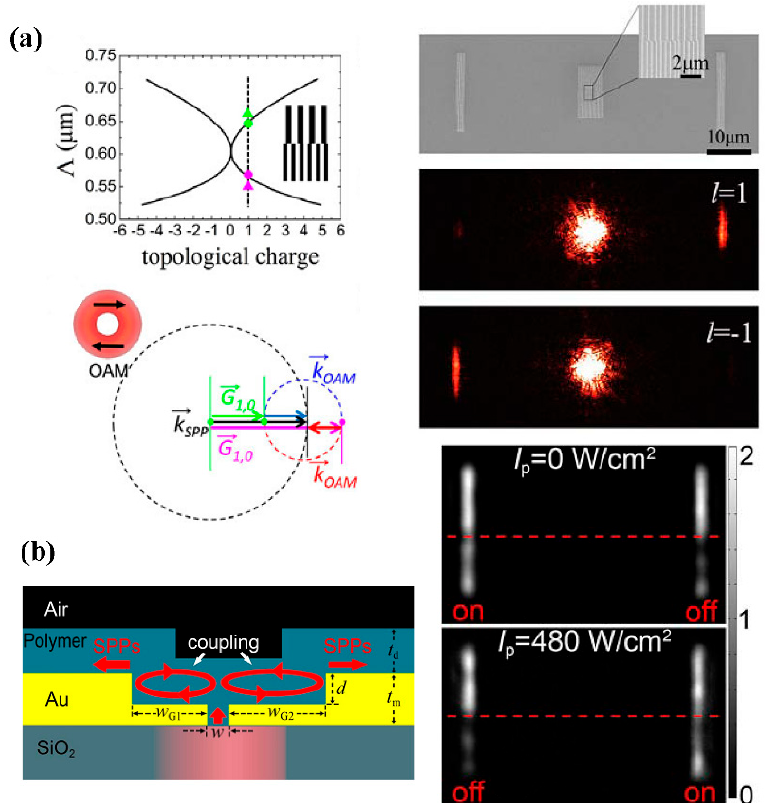
Figure 2. ( a ) Controlling the propagation direction of SPP by changing the topological charge of the incident vortex beam [82]; ( b ) Coating the slits with nonlinear polymer film, an all-optical directional SPP coupler can be achieved [91]. Reproduced with permissions from: [82], Wiley-VCH, 2018,